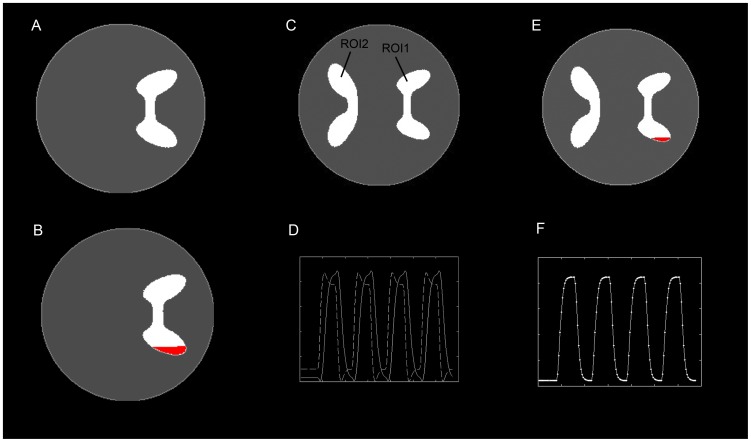
Pre-defined regions and the simulated fMRI response.(A) The predefined ROI for the simulated datasets including one task-related component. (B) One spatial reference with a 10% overlap rate applied to the simulated datasets including one task-related component. (C) The predefined ROI1 and ROI2 of the simulated datasets including two task-related components. (D) The simulated fMRI response added to the two ROIs. Solid line corresponds to the time course added to ROI1 and dotted line corresponds to the time course that was added to ROI2. (E) The spatial reference that was applied to the simulated datasets, including two task-related components. (F) The temporal reference that was applied to the simulated datasets, including two task-related components.